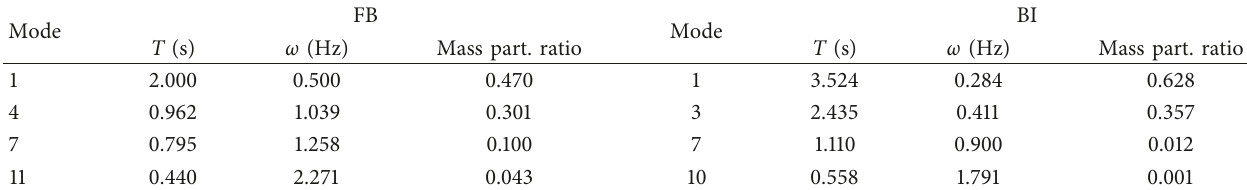
Table 2: Natural frequency of FFB and FBI systems considering the governor